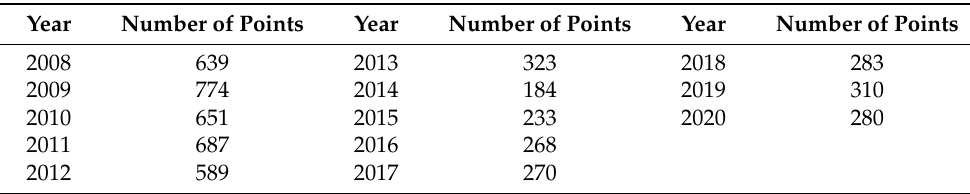
Table 1. Number of grasshopper outbreak points from 2008 to